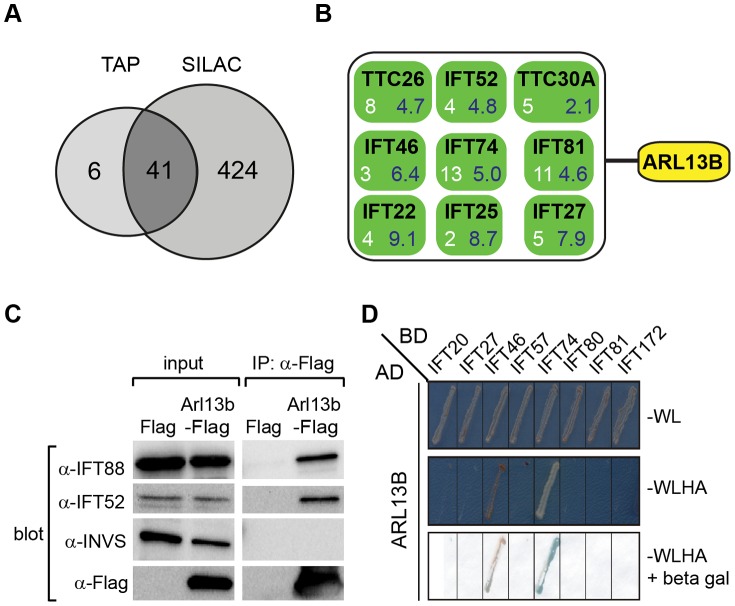
ARL13B associates with IFT-B complex via IFT46 and IFT74 interactions.(A) Number of proteins found to associate with SF (Strep-Flag)-tagged human ARL13B using TAP (tandem affinity chromatography) and SILAC (stable isotope labelling affinity chromatography) approaches in HEK293 cells. (B) ARL13B complexes possess IFT-B proteins. White number; average peptide count from 4 independent tandem-affinity purification experiments (details in Table 1). Blue number; average enrichment scores from 4 independent experiments employing a single purification/SILAC quantitative approach. TTC26 also known as DYF-13 in C. elegans, and TTC30A also known as IFT70 in Chlamydomonas. (C) Western blot from HEK293T cells transfected with Arl13b-Flag vector or Flag vector ‘mock’ control (Flag) showing that immunoprecipitated Flag-tagged ARL13B associates with IFT-B proteins (IFT88, IFT52) but not Inversin (INVS). (D) Dedicated yeast-two hybrid one-on-one analysis reveals direct interactions between human ARL13B and both IFT46 and IFT74. WL; minimal media lacking Trp and Leu. WLHA; minimal media lacking Trp, Leu, His and Ade.